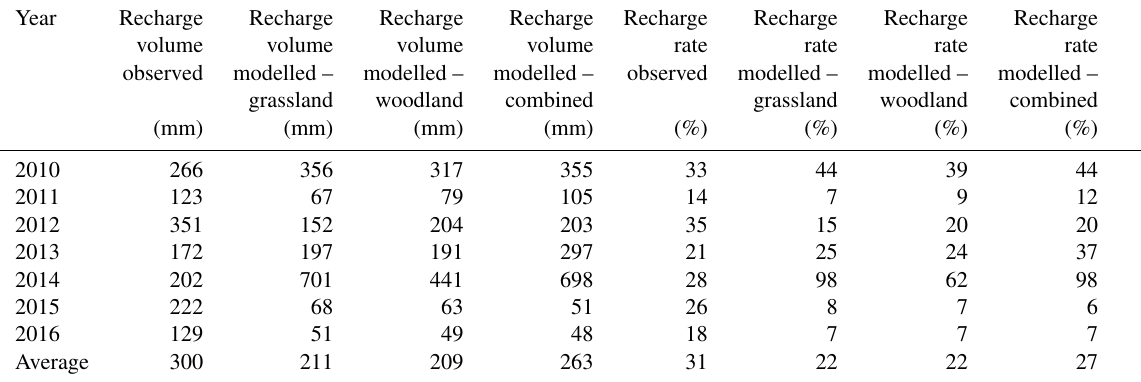
Table 3. Annual recharge volume and annual recharge rate calculated from measurements and simulated using the fitted drainage model for the grassland, woodland, and combined